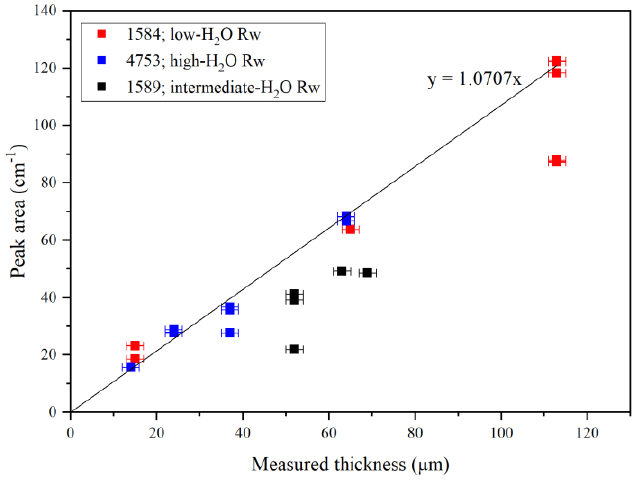
Figure 2. Integrated absorbance for the IR segment ~1850–1500 cm − 1 vs. measured thickness ( D m ) of the thin sections. The solid line simply collects the origin and the data point with the maximum absorbance and plate thickness.